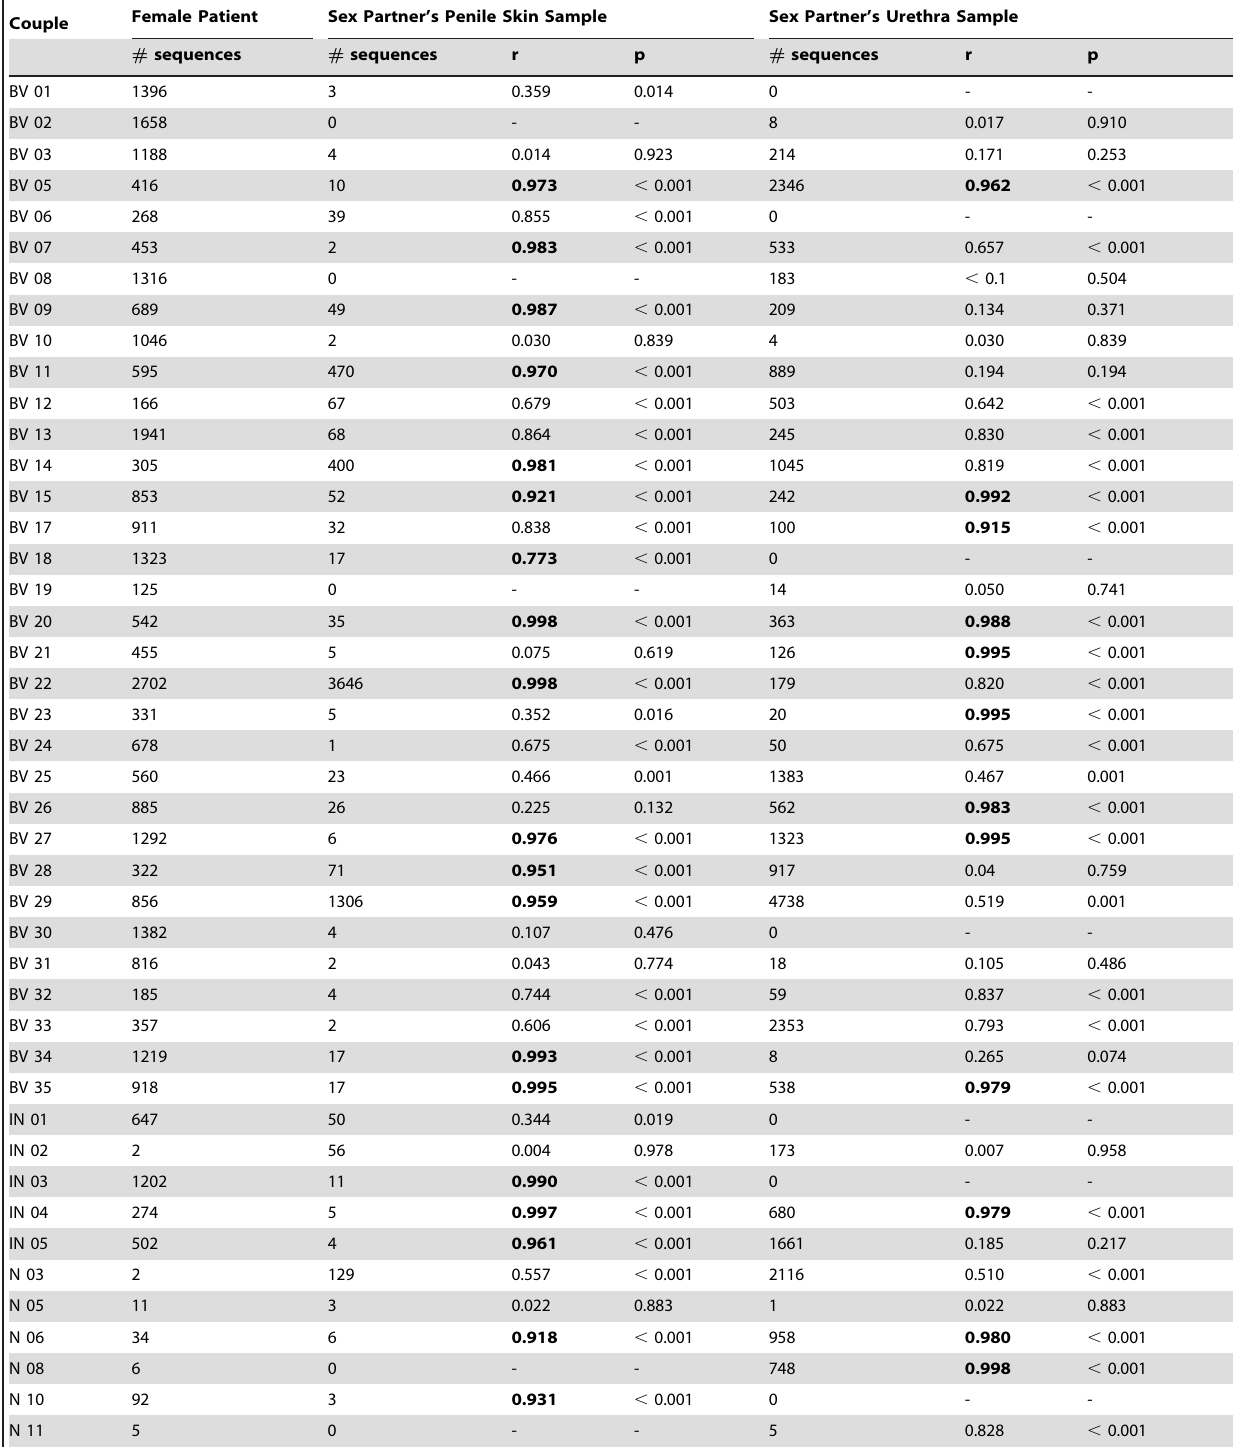
Couple Female Patient Sex Partner’s Penile Skin